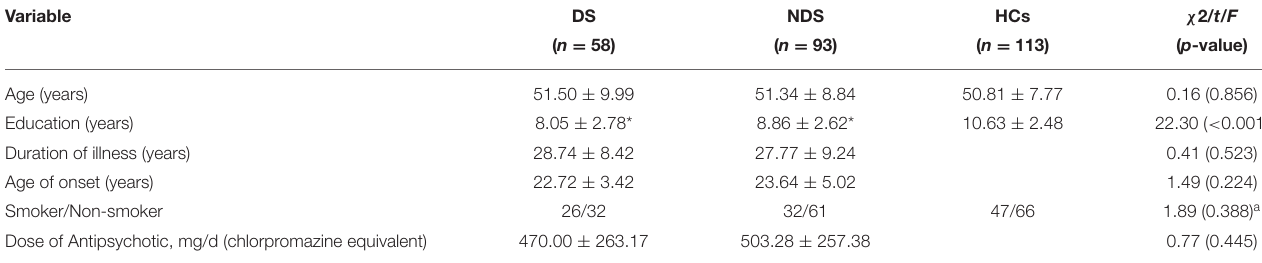
TABLE 1 | Demographic characteristics of DS, NDS, and HC. Variable